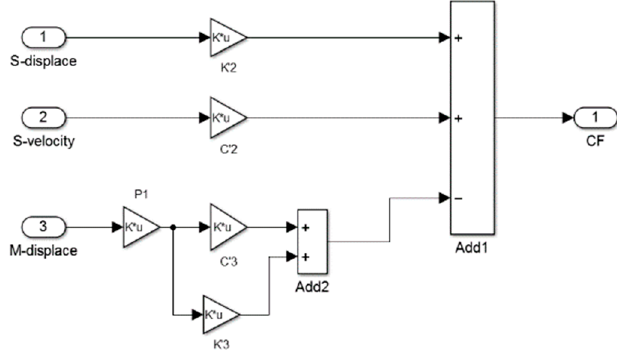
Figure 9. Passive control force simulation model.